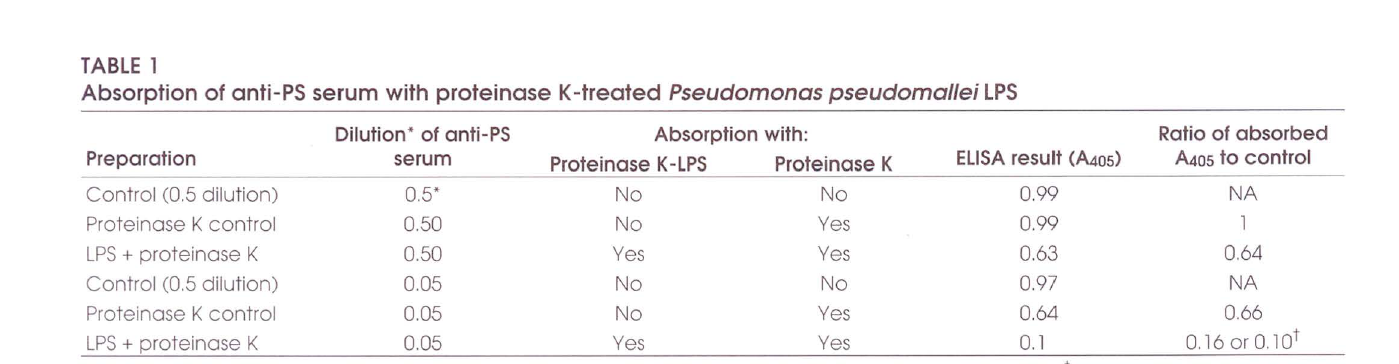
A4os to control